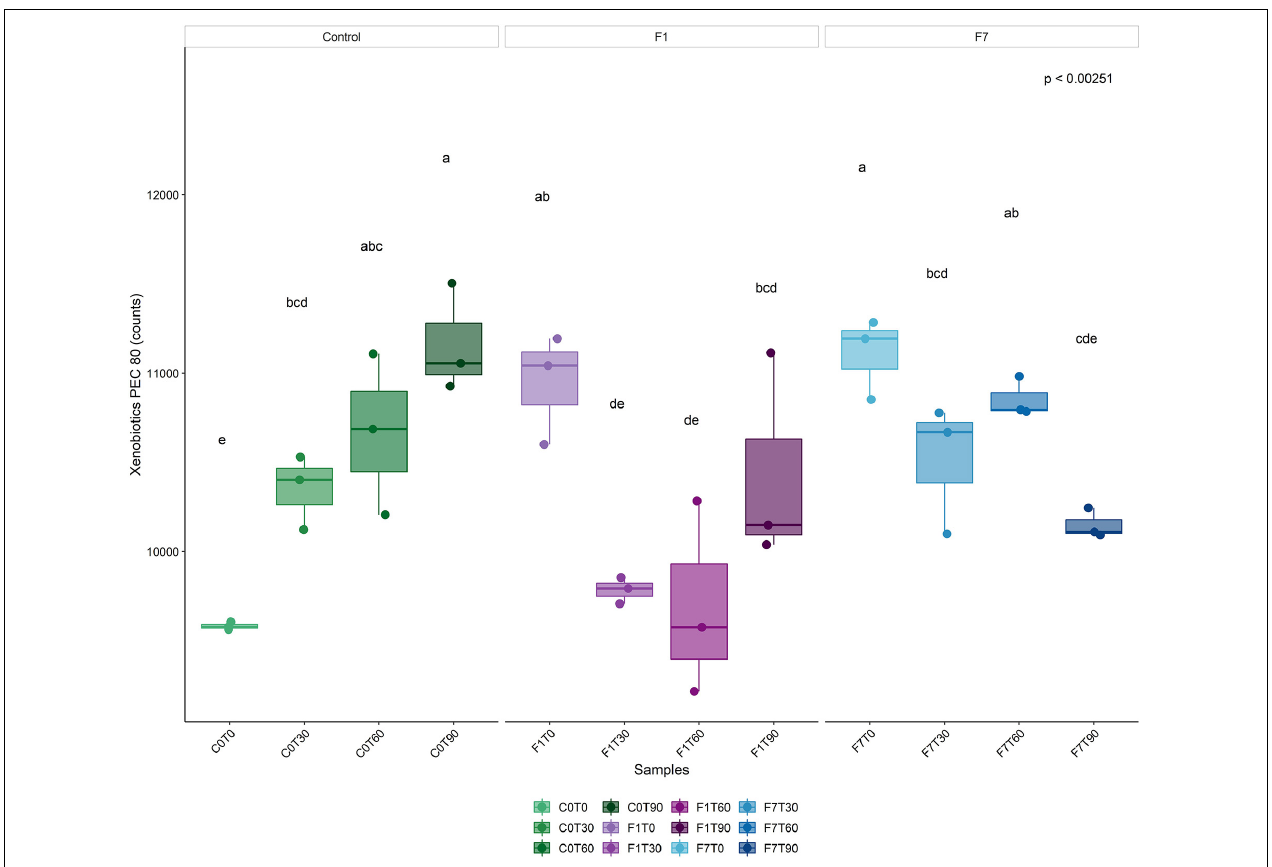
FIGURE 8 | Boxplot representing total bacterial contributions to Xenobiotic biodegradation functional profile (Level 2) with a Pathway Exclusion Cut-off (PEC) of 80% (i.e., only contributions that contain 80% of genes/enzymes that constitute the pathway are taken into account), as calculated by iVikodak server. Box and whiskers hinges represent first and third quartiles; upper and lower whiskers represent the furthest datapoints from median. Reported p -value is calculated by Kruskal–Wallis test ( α = 0.05). Group letters represent statistical significance at α = 0.05, based on Fisher LSD post-hoc test, with Benjamini–Hochberg correction for multiple comparisons: groups sharing one or more letters are not significantly